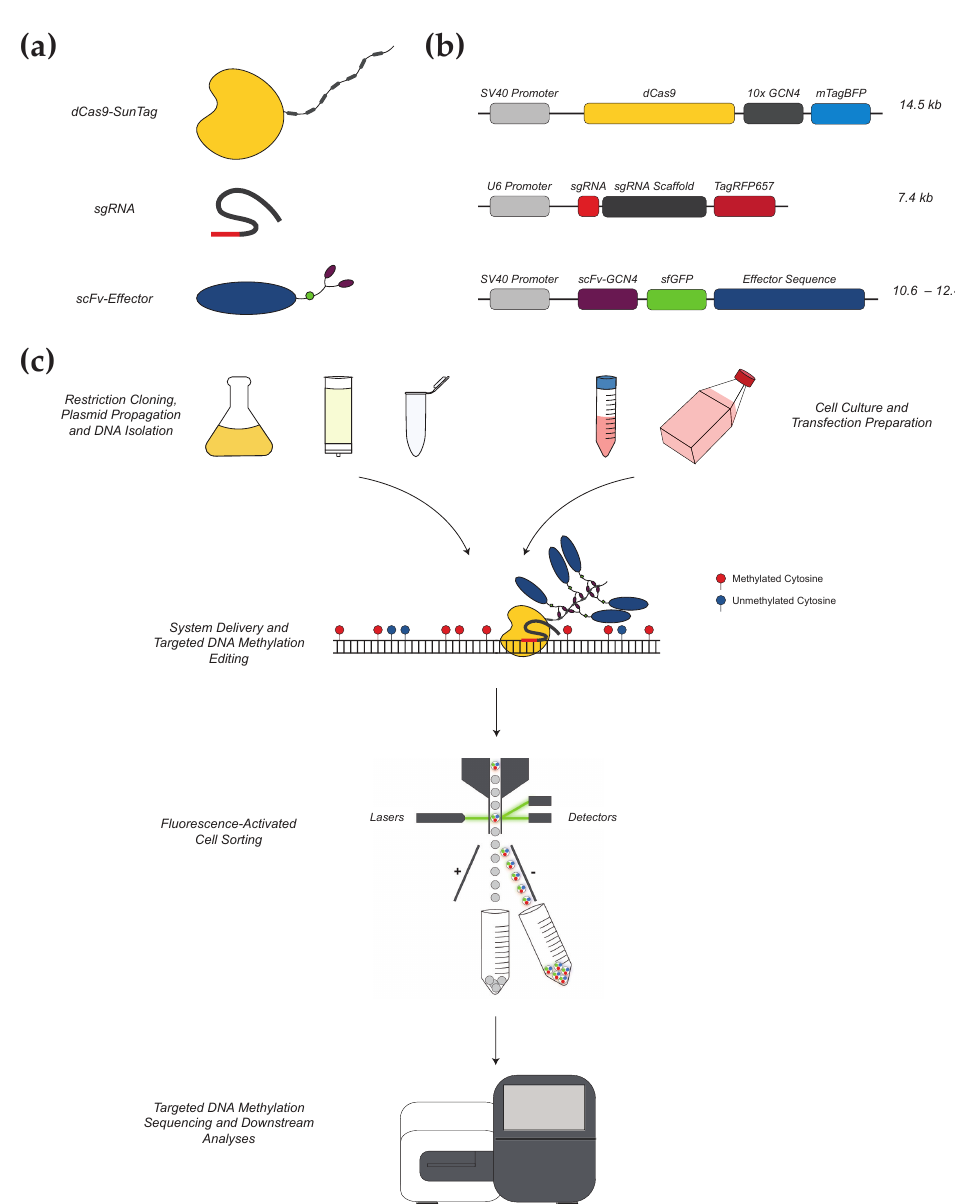
Figure 1. Overview of our CRISPR-based methylation editing approach. ( a ) Components of the CRISPR-methylation editing system. Shown are the three broad components of our editing system: a CRISPR-dCas9 construct for locus-specific targeting with an associated SunTag protein scaffold; a gRNA construct including a unique target sequence (red); and an effector protein construct (blue) with associated scFv domain (purple) for binding to the SunTag scaffold and tagged sfGFP fluorophore (green circle). ( b ) The structure and size of each plasmid is shown, corresponding to each of the respective constructs. ( c ) System components are cloned, propagated, and isolated as plasmid DNA for transfection into cultured cells, which provides transient delivery of each construct simultaneously to induce in vitro methylation or demethylation. A unique gRNA guides the CRISPR-dCas9-SunTag construct to bind at the target locus. Subsequently, multiple effector proteins bind to each respective GCN4 domain of the SunTag scaffold, wherein they can induce methylation change at surrounding CpG dinucleotides. Through modifying the effector enzyme, this system can be adapted for targeted DNA methylation or demethylation as desired. Post-transfection, cells positive for the expression of all components of the editing system are collected via fluorescence-activated cell sorting (FACS) and used for downstream analyses, including targeted DNA methylation